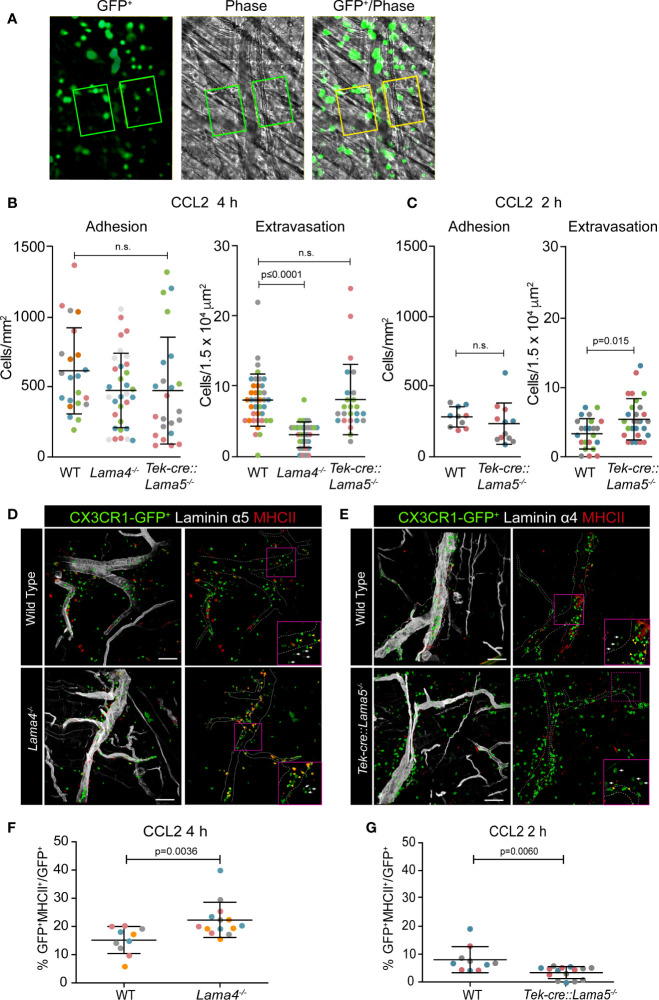
Intravital microscopy of CCL-2 induced monocyte extravasation in cremaster muscle postcapillary venules of Lama4−/− or Tek-cre::Lama5−/− hosts carrying CX3CR1GFP/+ bone marrow. (A) Representative fluorescence and corresponding phase contrast images from movies of CX3CR1-GFP+ cells extravasating across postcapillary venules of the cremaster muscle; boxed areas, extending from the border to 75 μm either side of postcapillary venules for a length of 100 μm, were used to quantify extravasated CX3CR1-GFP+ cells; scale bars = 50 μm; n.s. = non-significant. Quantification of adherent and extravasating CX3CR1-GFP+ monocytes at (B) 4 h and/or (C) 2 h post-application of CCL2. Data are means ± SD from five WT mice and four mice for each chimera with four to eight postcapillary venules examined/mouse at 4 h and three to four WT and chimeric mice with three to four postcapillary venules examined/mouse at 2 h. (D, E) Excised tissues were immunofluorescently stained for MHCII and laminin α5 or α4 to identify CX3CR1-GFP+MHCII+ extravasating cells in relation to the endothelial basement membrane; dotted lines denote vessel borders; boxed areas are shown in inserts in the lower right hand corners at high magnifications to illustrate patrolling (yellow arrowheads) versus inflammatory monocytes (white arrows); scale bars = 50 μm. (F, G) Quantification of proportions of CX3CR1-GFP+MHCII+ cells expressed as percentage of total GFP+ cells in Lama4−/− or Tek-cre::Lama5−/− hosts. Data are means ± SD from four WT and four chimeric mice with two to four postcapillary venules examined/mouse in (F) and three WT and three chimeric mice with three to seven postcapillary venules examined/mouse in (G). In (B, C, F, G) each dot or square denotes one mouse and the different experiments are marked by different colors; significance was calculated using Mann-Whitney tests as not all data passed the normality test by D`Agostino & Pearson; the exact p-values are shown in the graphs.